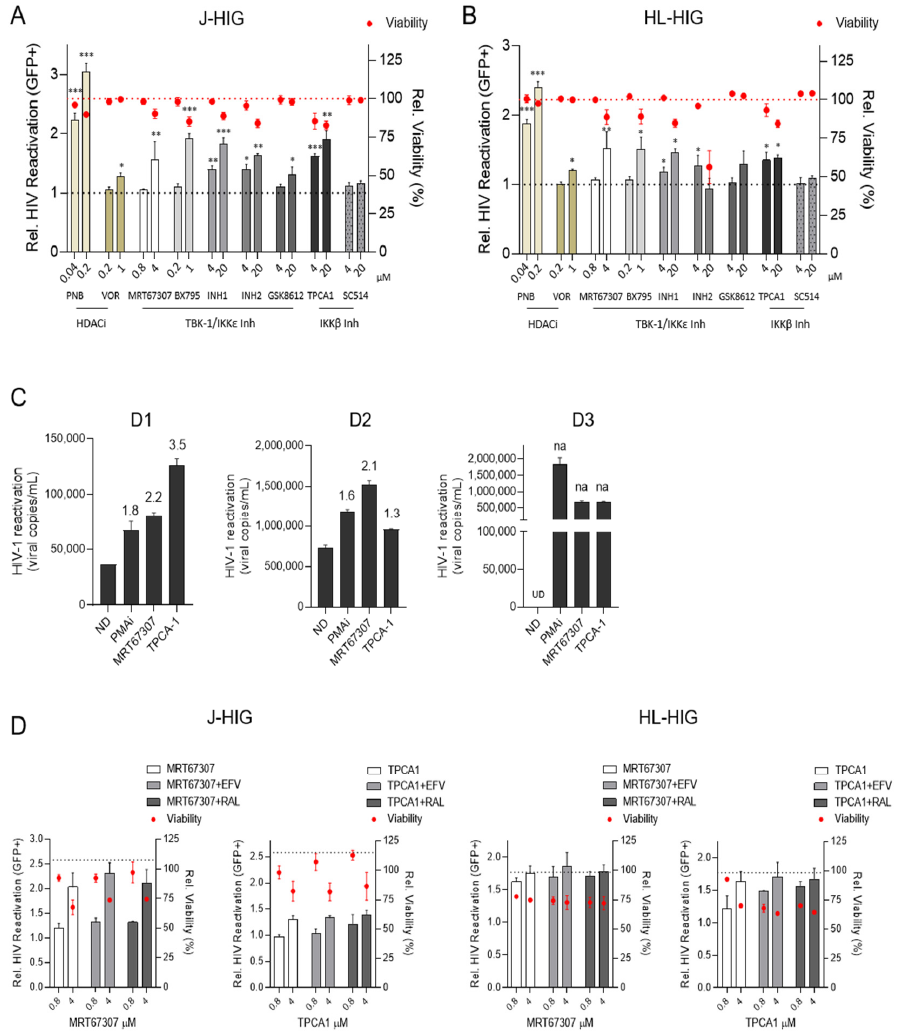
Figure 1. IKK Inhibitors induce HIV reactivation in in vitro and ex vivo models of latency. ( A ) HIV reactivation induced by IKKis in latently infected lymphoid Jurkat (J-HIG) and ( B ) myeloid HL-60 (HL-HIG) cells. The activity of IKKis MRT67307, TPCA-1, BX795, Inh 1, Inh2, GSK8612 and SC514 was determined by the quantification of GFP+ cells (%) after culturing J-HIG or HL-HIG cells with IKKis for 24 h. HDCAi panobinostat (PNB) and vorinostat (VOR) were used as controls for HIV-1 reactivation. Basal reactivation (grey-dashed line) in J-HIG and HL-HIG was established according to the no-drug condition (ND). Toxicity of IKKis (red-dashed line) in J-HIG and HL-HIG cells was measured as percentage of viable cells (LIVE/DEAD™ staining) by flow cytometry related to the ND condition. ( C ) Ex vivo viral reactivation capacity of IKKis in CD4+ T cells from HIV+ individuals. HIV-RNA copies were determined in the cell culture supernatant from HIV+ CD4+ T cells incubated for 72 h with 4 µM of MRT67307 or TPCA-1. PMA/ionomycin (50 ng/mL/1 µM, PMAi) was used as the positive control of HIV-1 reactivation. Fold-change (FC) relative to ND are indicated above each bar for the respective treatment conditions. FC values, if not available (na) because of undetermined RT-qPCR ct values (UD), are highlighted in the chart. ( D ) HIV-1 reactivation capacity of IKKis in the presence of antiretroviral drugs. Reactivation ability of MRT67307 (4 µM) and TPCA-1 (4 µM) is not affected by the ART (efavirenz, EFV at 0.3 µM or raltegravir, RAL at 2.2 µM), neither in latently infected lymphoid J-HIG (left panel) nor myeloid HL-HIG cells (right panel). Viral reactivation was measured 24 h after incubation with the corresponding conditions. The grey-dashed line indicates reactivation in the PMAi control. Red dots indicate relative cell viability. Mean ± SD of three independent experiments is shown. * p < 0.05; ** p < 0.01; *** p < 0.001.